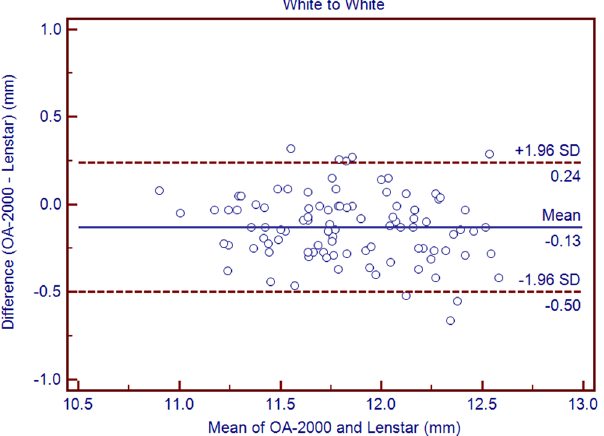
Figure 4. Bland-Altman plots show the agreement between OA-2000 swept-source optical coherence tomography and Lenstar optical low coherence reflectometry for measuring white-to-white. Solid lines represent the bias between both devices and dotted lines represent the 95% confidence interval for the difference.